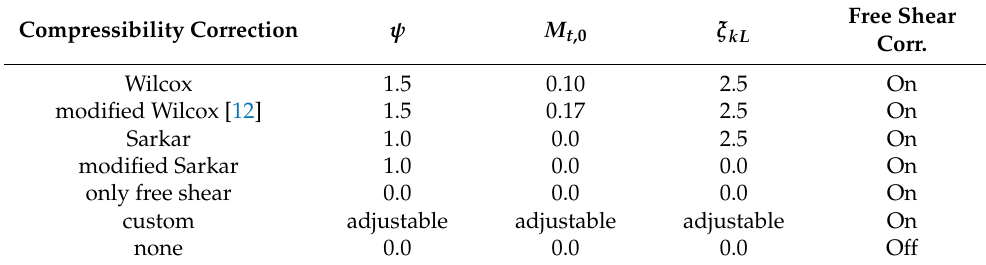
Table 3. Compressibility correction option parameters in the current